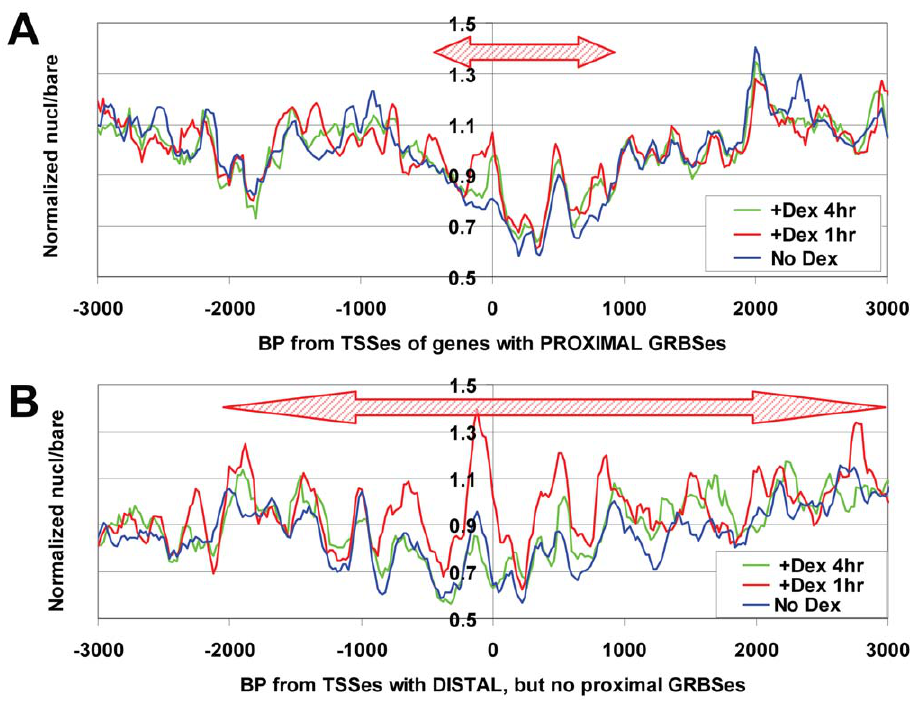
Figure 5. Proximal GRBSes are associated with a lesser increase in nucleosome occupancy after Dex. Nucleosome density relative to TSSes was plotted for either: ( A ) all genes that contain a GR-binding site within 500 bp upstream of the TSS (top panel, SDPR , SLC19A2 , SRGN , GEM & POMC – MMTV was excluded because of the presence of luciferase and vector sequences, and lack of knowledge of the insertion site), or ( B ) all genes that lack a promoter proximal GR-binding site, but which have a GR-binding site . 1 kb upstream of the TSS (bottom panel, HSD11B2 , SGK1 , TSC22D3 & PLK2 ).